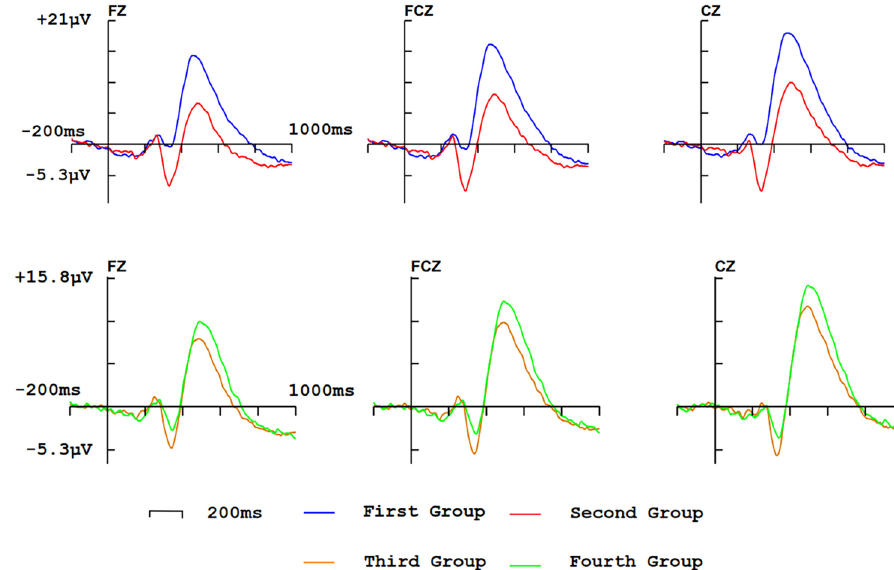
Fig. 7 ERP waves on Fz, FCz, Cz (electrodes that are used to analyze P2 component) in each